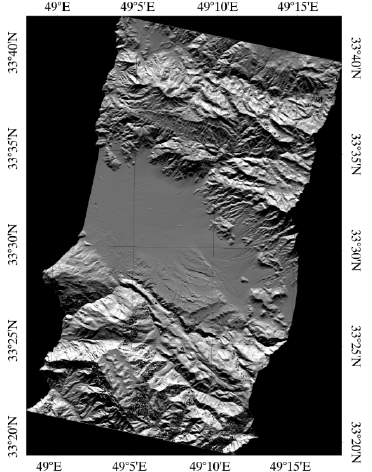
Figure 1: Shaded relief map of TanDEM-X DEM